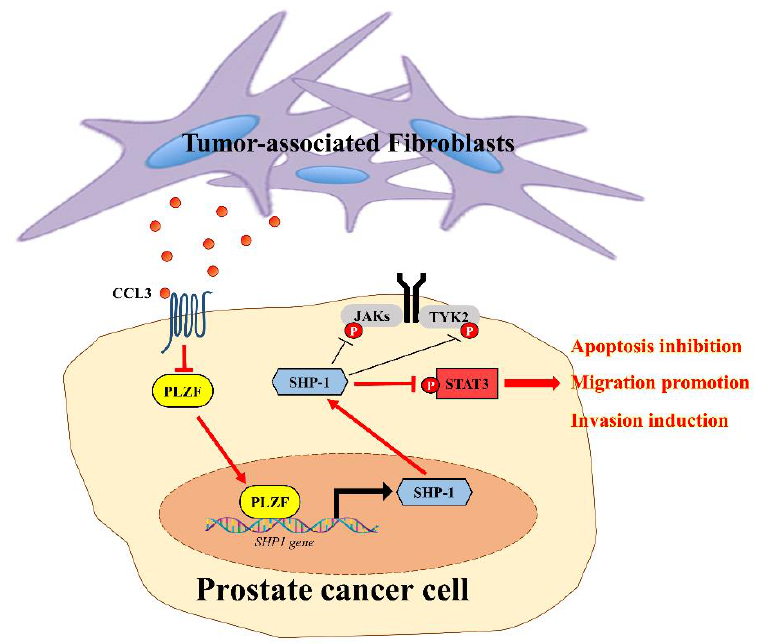
Figure 7. A schematic illustration of the tumor suppressor PLZF actions in prostate cancer progression. Figure S1: PLZF was downregulated in prostate tumors and negatively correlated with pY-STAT3, Figure S2: Exogenous transfection with PLZF reduces cell proliferation, migration ability, and MMP9 / 11, and which ECM component degradation enzymes, Figure S3: Prostate cancer cells are a ff ected by fibroblasts to produce soluble factors and reduce PLZF expression, Figure S4: Identification of tumor-associated fibroblast-derived cytokines, Figure S5: Original blots for western blot analyses shown in Figure 1, Figure S6: Original blots for western